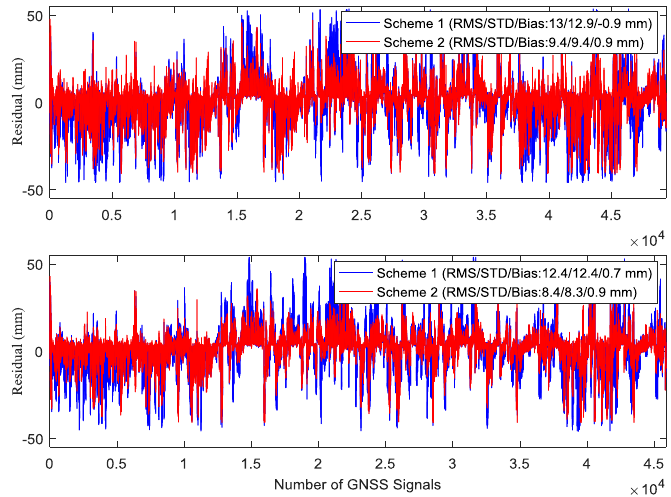
Figure 6. Residuals of the slant wet delay for the station of BAIY using two schemes with 10° (top) and 15° (bottom) elevation angle mask over the experimental period of Doy 303 to 317, 2015.